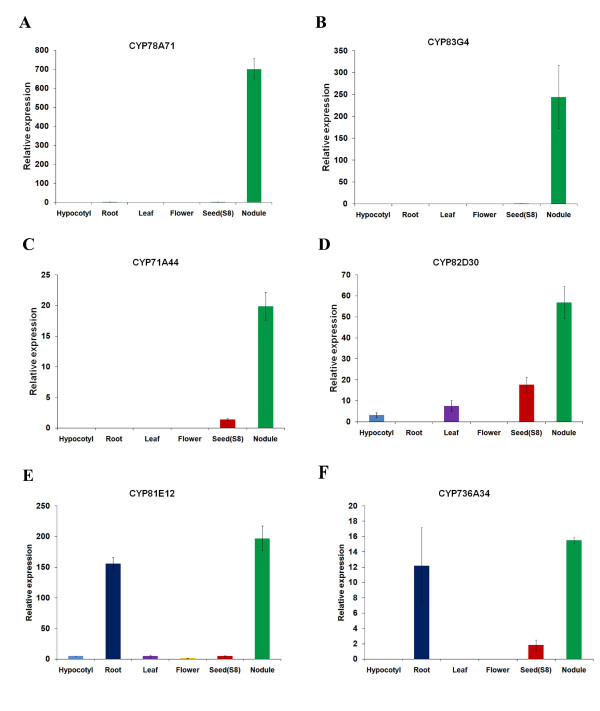
qRT-PCR confirmation of soybean P450 genes highly expressed in root and nodule as revealed by the analysis of Microarray and Solexa transcriptome datasets. Error bars represent SE (Standard error) of three replications.